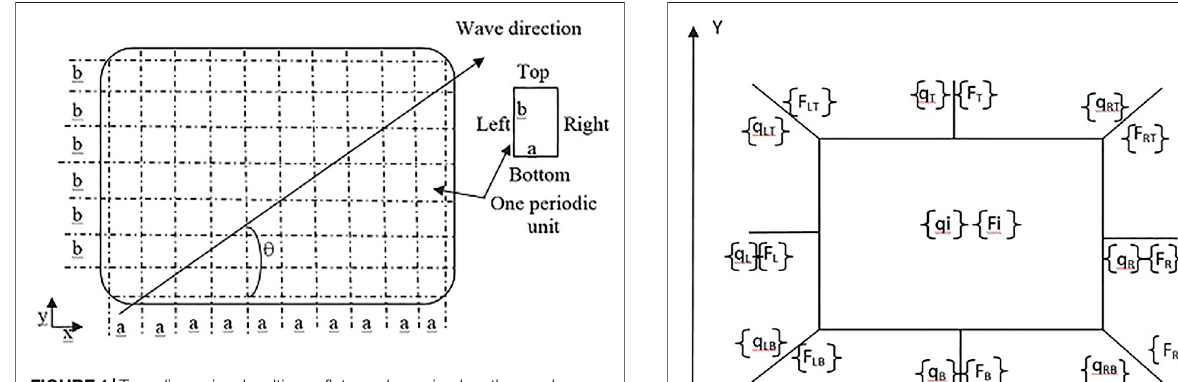
FIGURE1| Two-dimensionalmultispan fl atpanelsonsimpleorthogonal line supports.